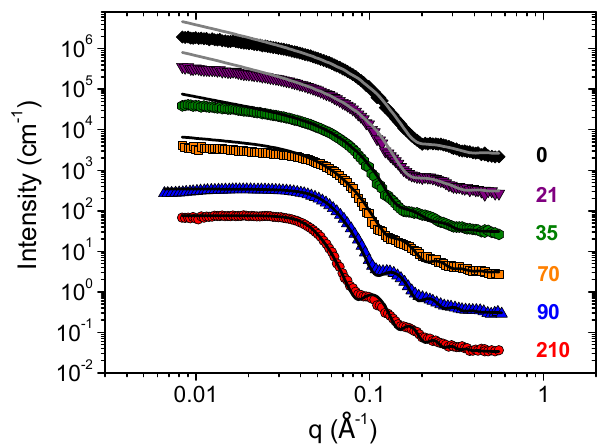
Figure 2. Scattering curves for 117 mM C8TAB and 78 mM potassium oleate solutions in D 2 O containing different amounts of added n-decane indicated in the figure (in mM), at 20 °C. Solid lines represent fits of the scattering curves by models of an elliptical cylinder (0 and 21 mM n-decane), a mixture of elliptical cylinders and core-shell ellipsoids (35 and 70 mM n-decane) and charged core-shell ellipsoid (90 and 210 mM n-decane). Parameters of fits are presented in Table 1. Table 1. Parameters of aggregates formed in 117 mM C8TAB and 78 mM potassium oleate aqueous solutions in the presence of different n-decane concentrations obtained from SANS data.